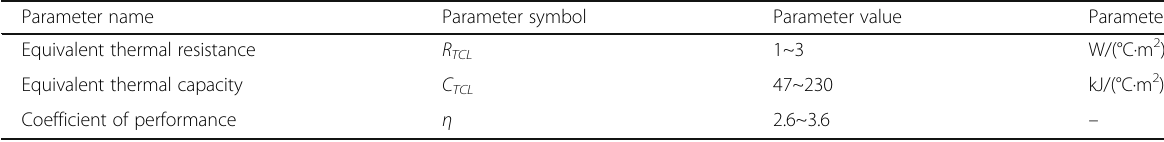
Table 1 The typical values of the thermal